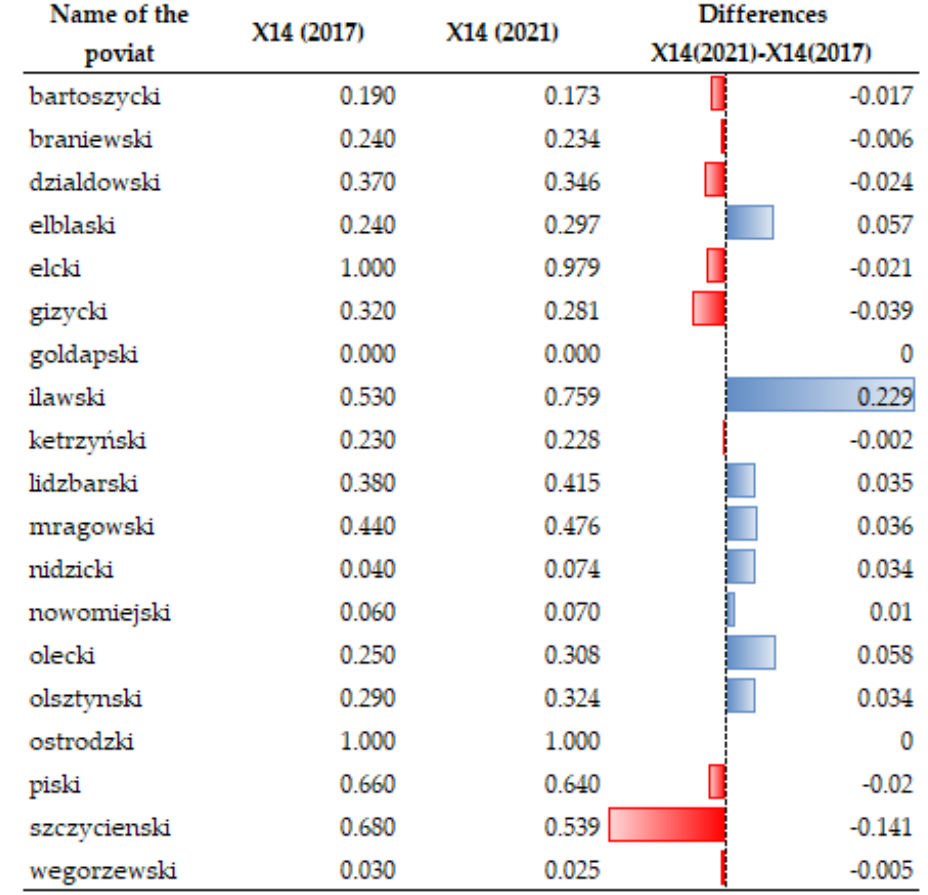
y = 0.0215x + 0.5599